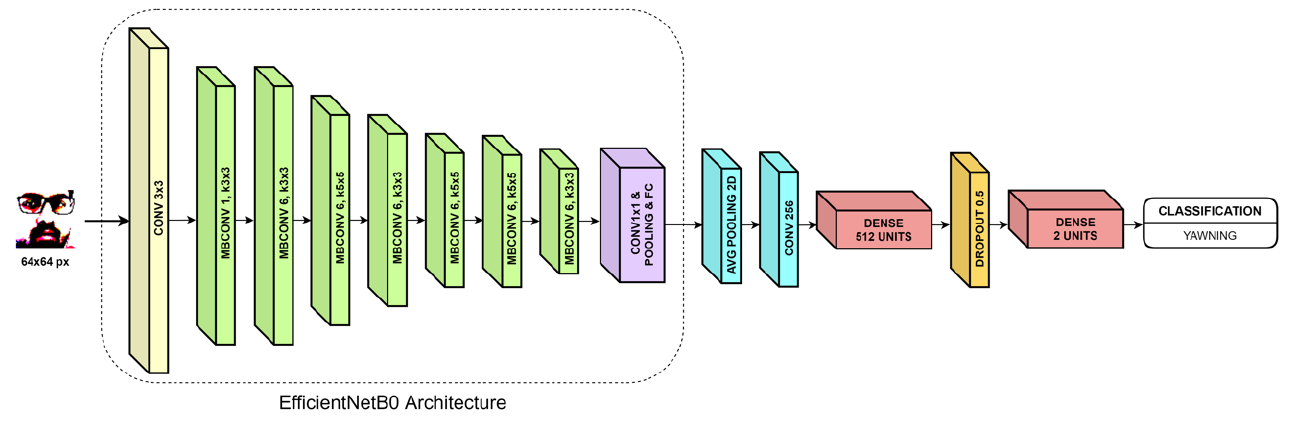
Figure 8. Architecture of the model used for yawning